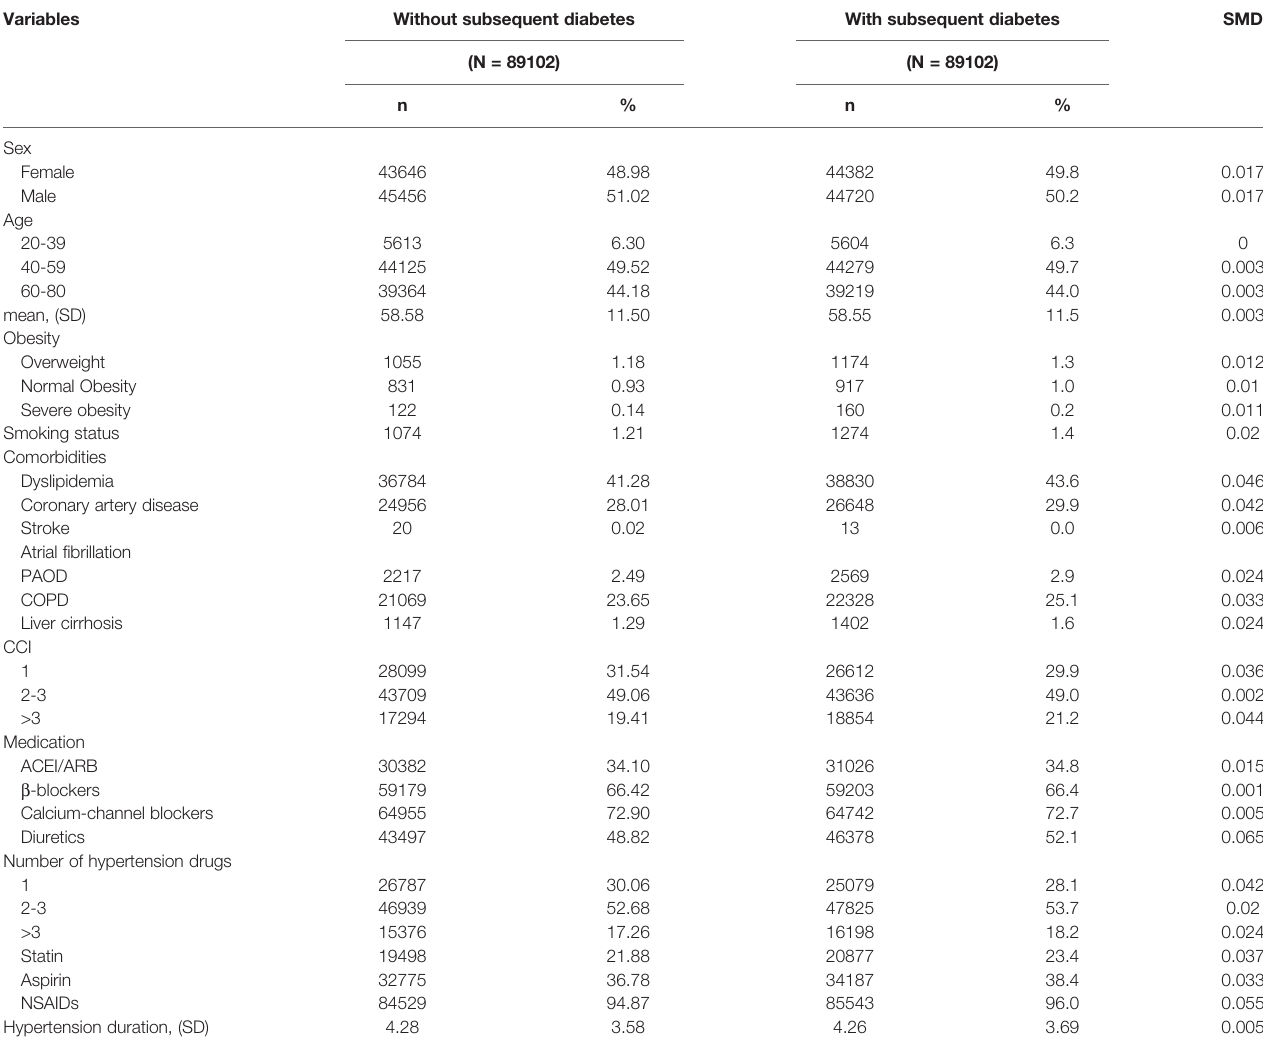
TABLE 2 | Comparison of baseline characteristics of the study subjects in the hypertension cohort. Variables Without subsequent diabetes With subsequent diabetes SMD